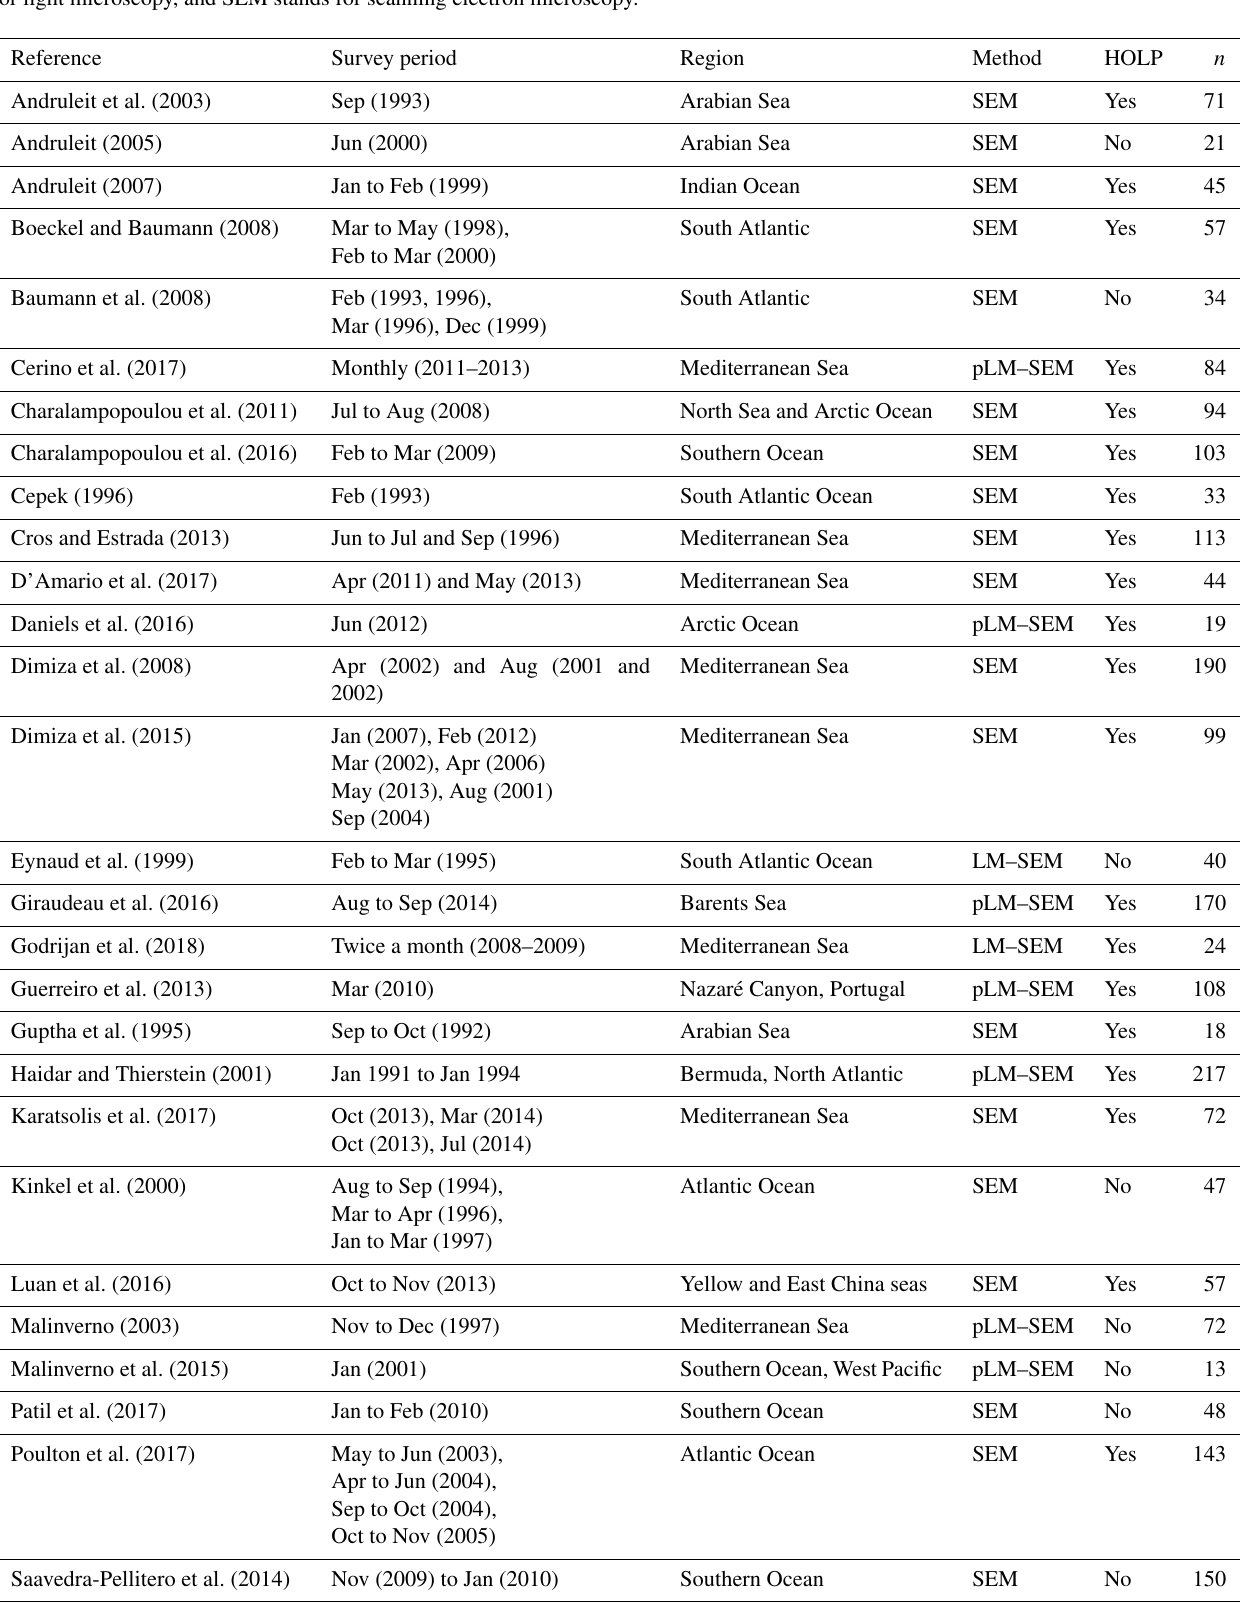
Table 1. Overview of metadata. The following abbrevations are used within this table: pLM stands for polarized light microscopy, LM stands for light microscopy, and SEM stands for scanning electron